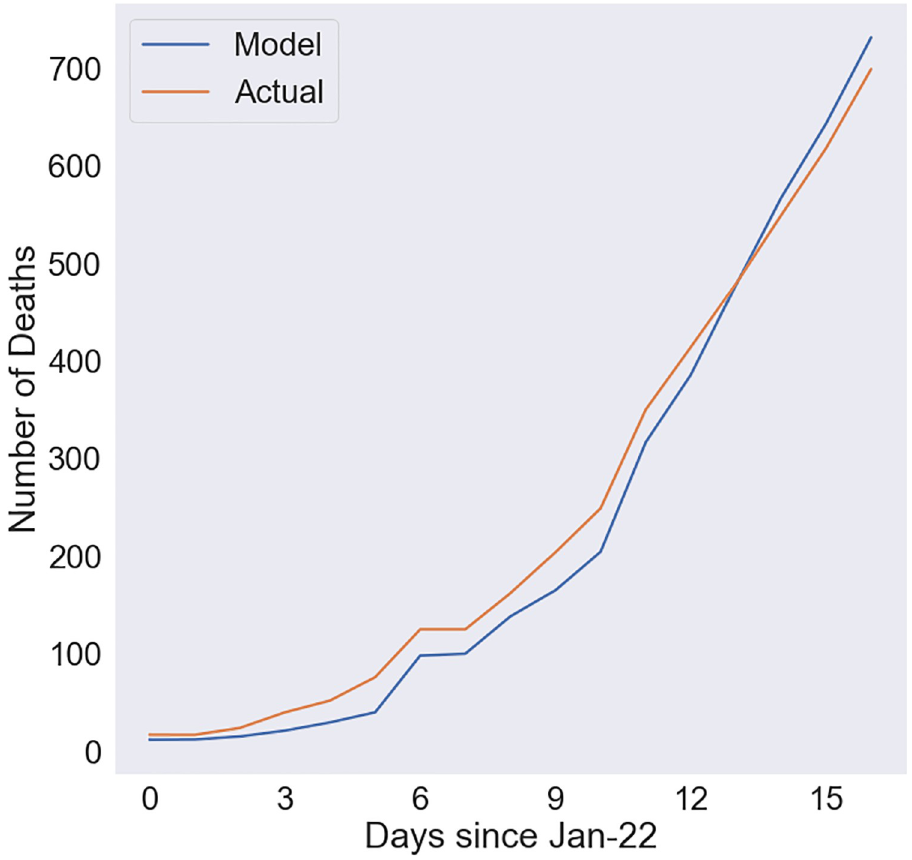
Fig 3. Comparison of modeled and actual number of deaths for the early stage case. Used data from January 22 through February 8.